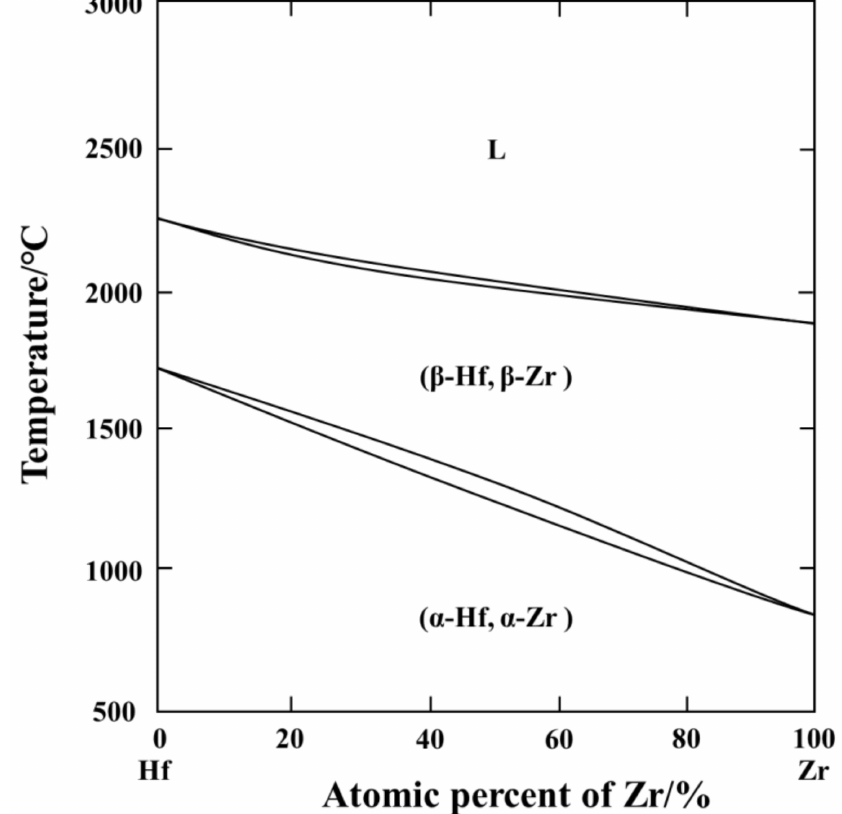
Figure 3. The Zr-Hf phase